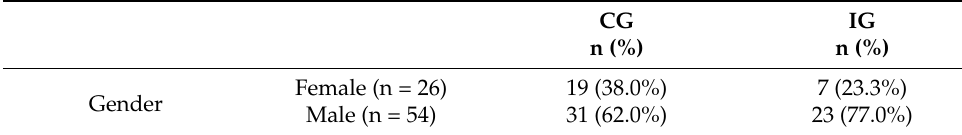
Table 2. Frequencies by group, gender, and age of